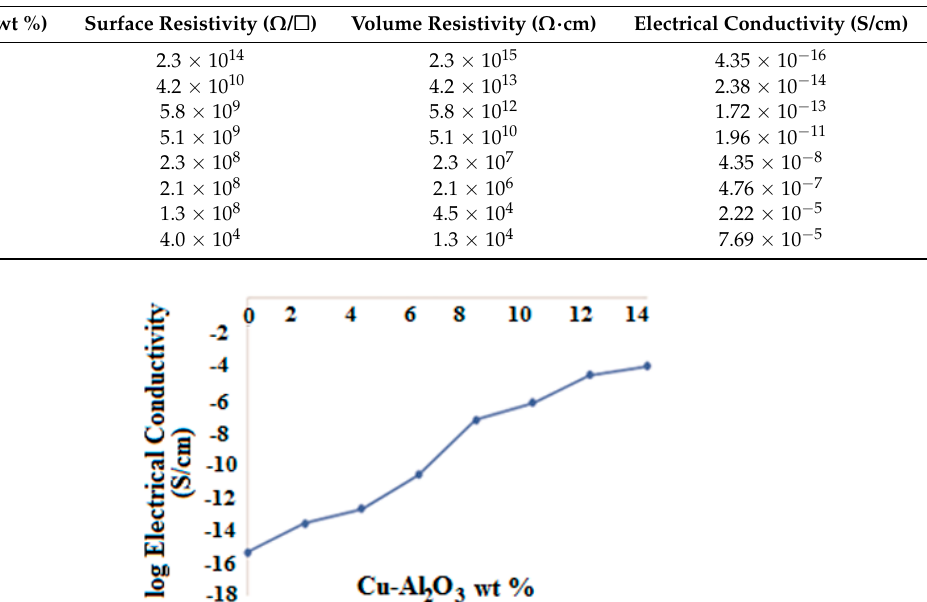
Table 3. Surface/volume resistivity and electrical conductivity of Cu–Al 2 O 3 /PS- b -(PE- r -B)- b -PS- g -MA composites.